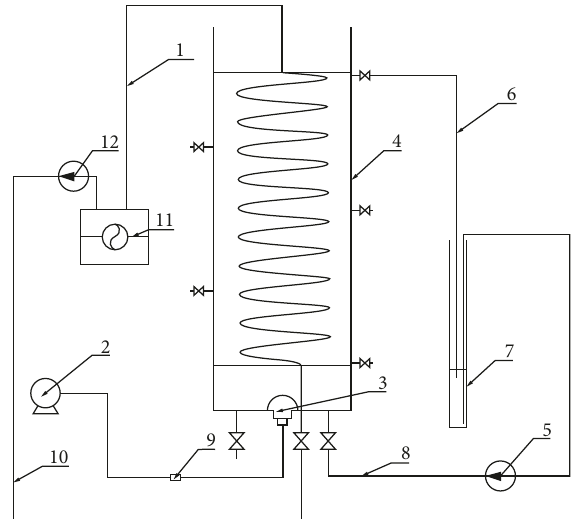
Figure 1: BPFS preparation device. 1, circulating water outlet pipe; 2, electromagnetic air pump; 3, microporous aerator; 4, bioreactor; 5, electromagnetic diaphragm pump; 6, drainpipe; 7, circulation collector; 8, liquid inlet tube; 9, rotameter; 10, cir- culating water inlet pipe; 11, thermostatic waterbath; 12, im- mersible